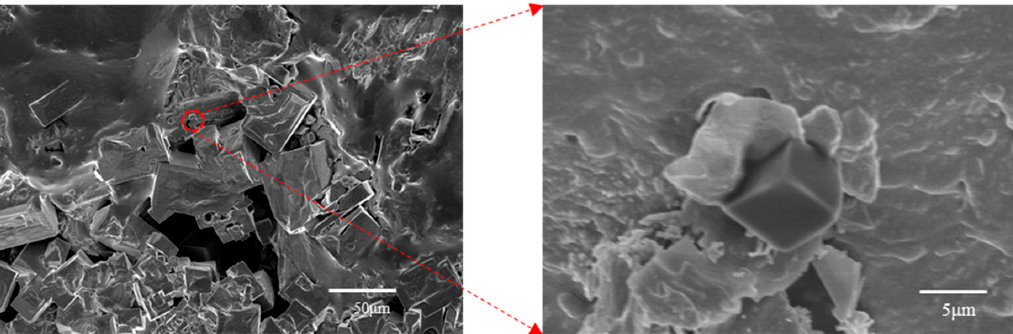
Figure 15. Salt crystal attached to pore wall. Figure 15 Salt crystal attached to pore wall. Figure 15 Salt crystal attached to pore wall.